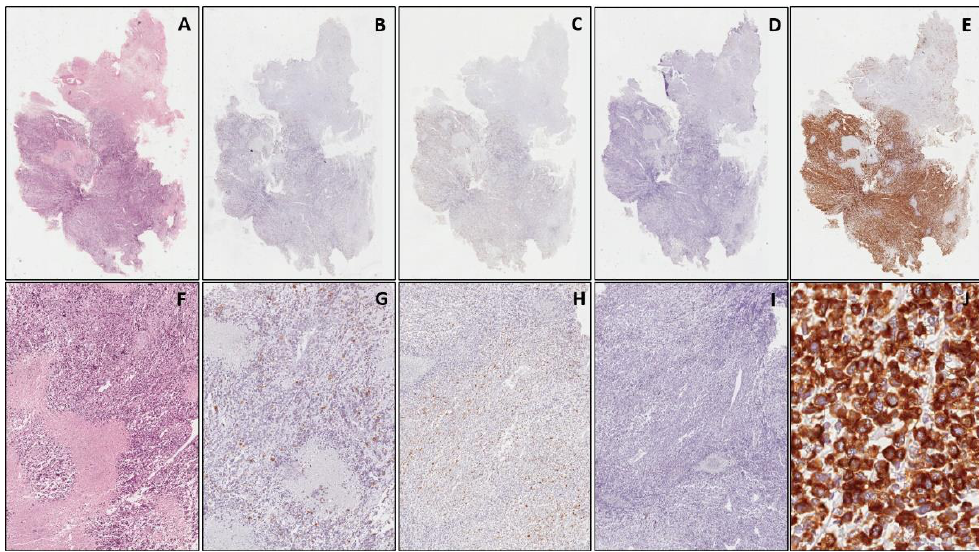
Figure 4. Embryonal rhabdomyosarcoma. Serial sections from a small biopsy, stained with hema- toxylin & eosin at low ( A ) and higher ( F ) magnification. Neoplastic cells show focal expression of desmin (( B , G ), at low and higher magnification, respectively) and myogenin (( C , H ) at low and higher magnification, respectively) while no staining for MyoD1 (( D , I ), at low and higher magnifi- cation, respectively). In ( E ) (low magnification) and (J) (higher magnification), diffuse and strong cytoplasmic expression of WT1. ( A – E : original magnification 40×; F – I : original magnification 100×; J : original magnification 200×).